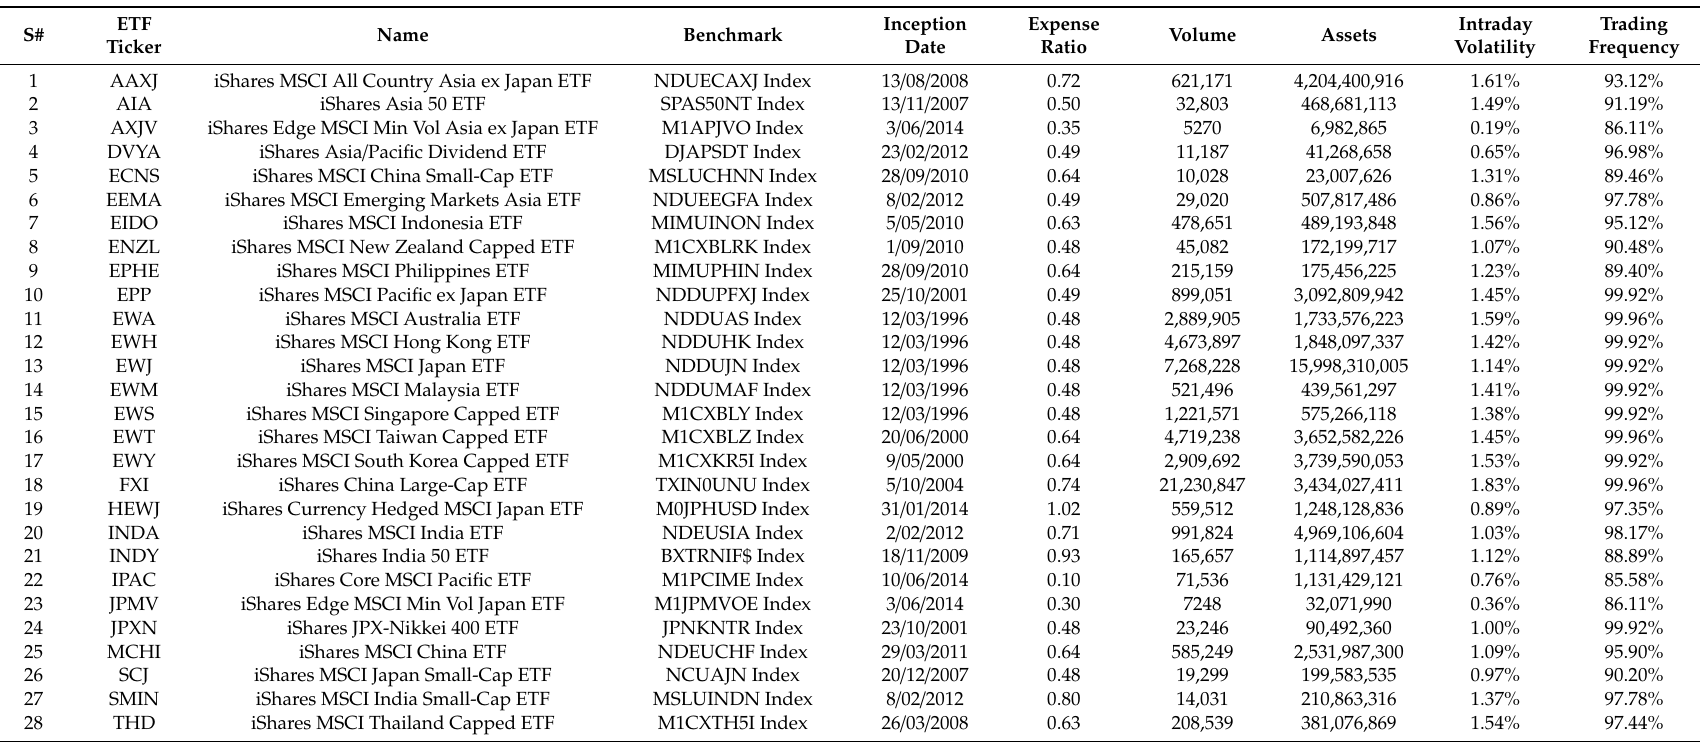
Table A1. Profiles of International ETFs Tracking Asia-Pacific